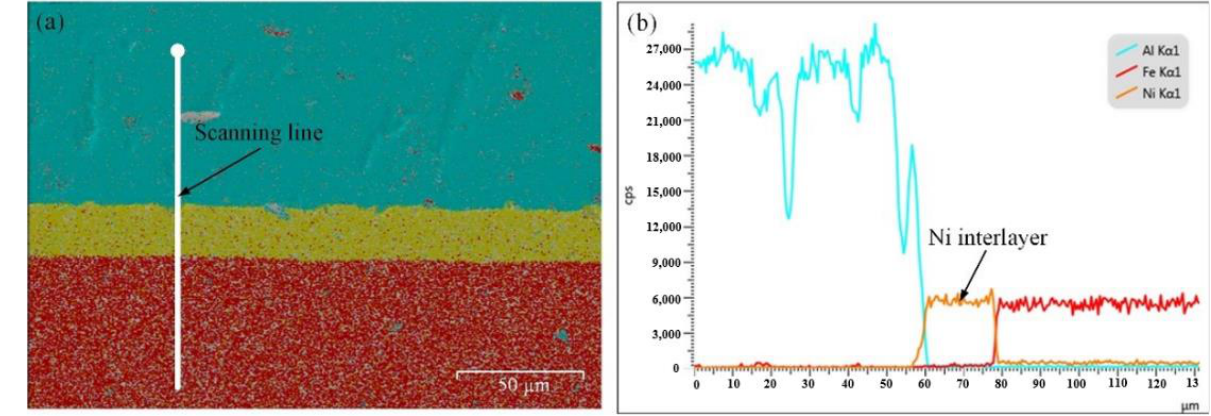
Figure 6. EDS analysis of region C at 800 rpm: ( a ) area scan and ( b ) line scan.